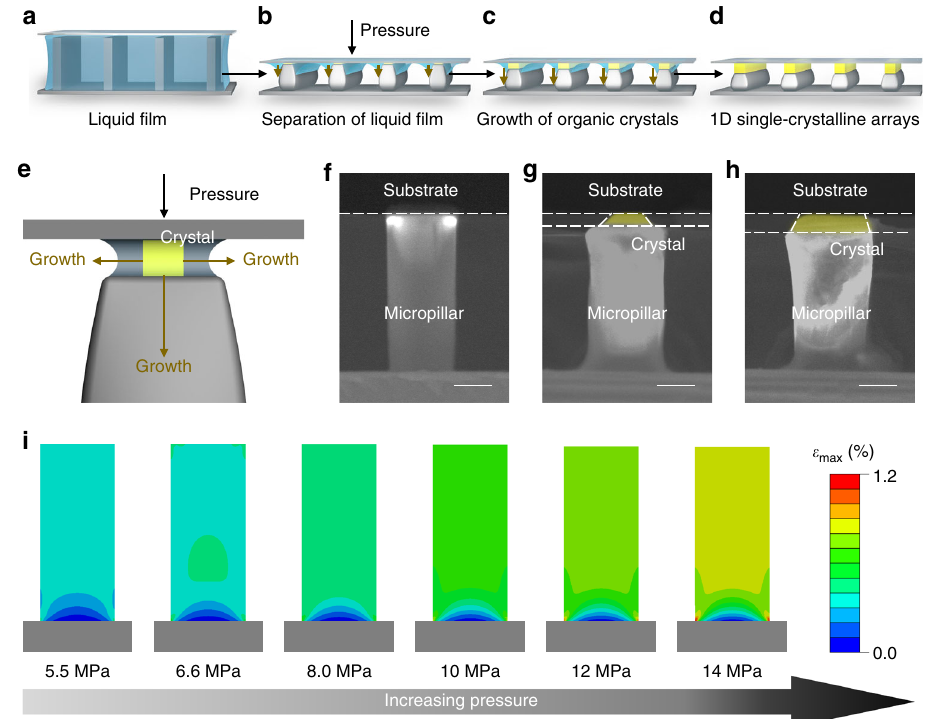
Fig. 1 Controlled dewetting process for assembling 1D organic arrays. a – d Schematic illustration of 1D organic arrays assembly processing under pressure. e Zoom-in schematic illustration of 1D organic crystal nucleus growing in the con fi ned space. f – h ESEM images with cross-sectional view of organic nanostructure growing on an individual micropillar, showing the assembly under pressure. i Simulated maximum principal strain of a typical photoresist pillar. Strain of the micropillar increasingly exhibits at the bottom, especially for associative part of the pillar and silicon substrate with pressure increasing from 5.5 to 14 MPa. Scale bars: f – h 3 μ